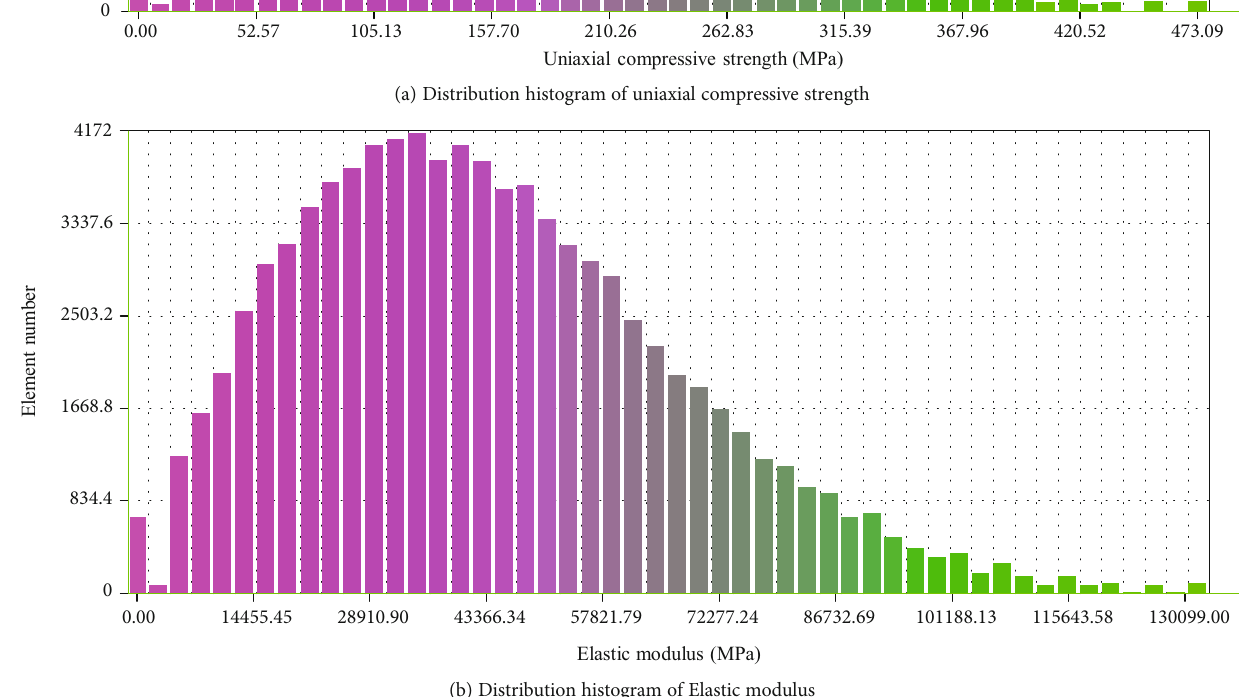
Figure 4: Distribution of histogram of UCS and elastic